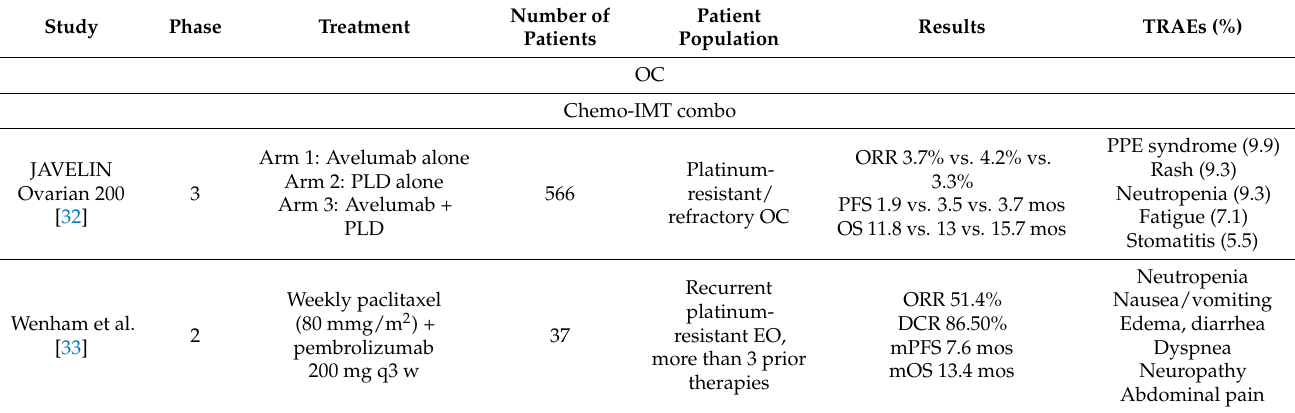
Table 1. Reported immune checkpoint inhibitors and vaccine therapy studies in gynecological